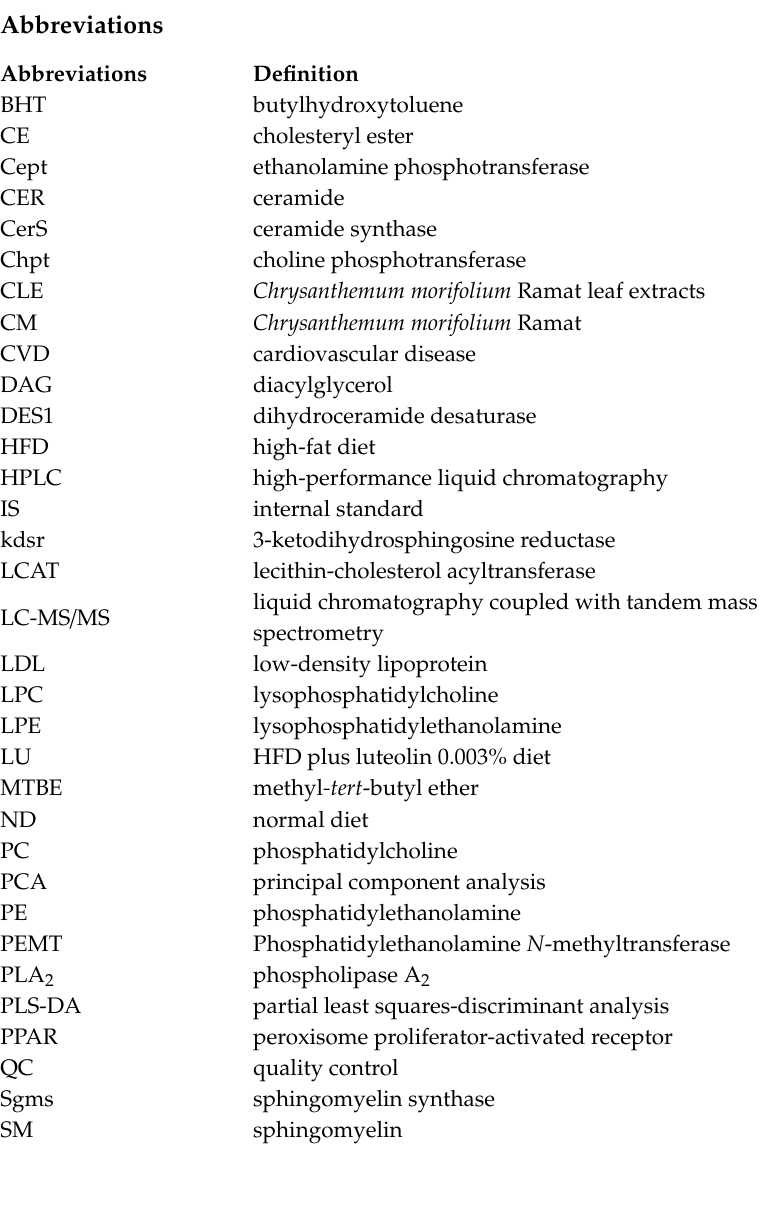
Figure S1: E ff ect of Chrysanthemum morifolium Ramat leaf extracts (CLE) and Luteolin (LU) supplements for 16 weeks on individual TAG species in the liver. *, # di ff erent letters indicate significant di ff erence compared with normal diet (ND) group (*) and HFD groups (#), as determined by Tukey’s multiple comparisons test (*** p < 0.001, # p < 0.05, ## p < 0.01, ### p < 0.001). Table S1: Identified potential lipid biomarkers in plasma indicating statistically significant di ff erence among sampling